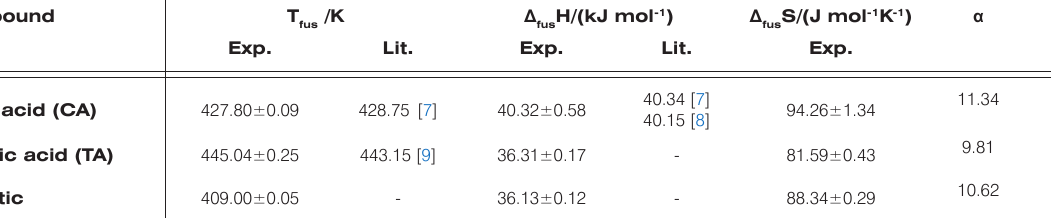
Table 1. Melting points, enthalpy of fusion and entropy of fusion of pure components and eutectic mixture. Compound